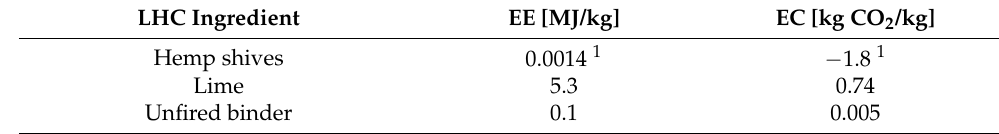
Table 1. EE and EC values for the ingredients of LHC with unfired binders